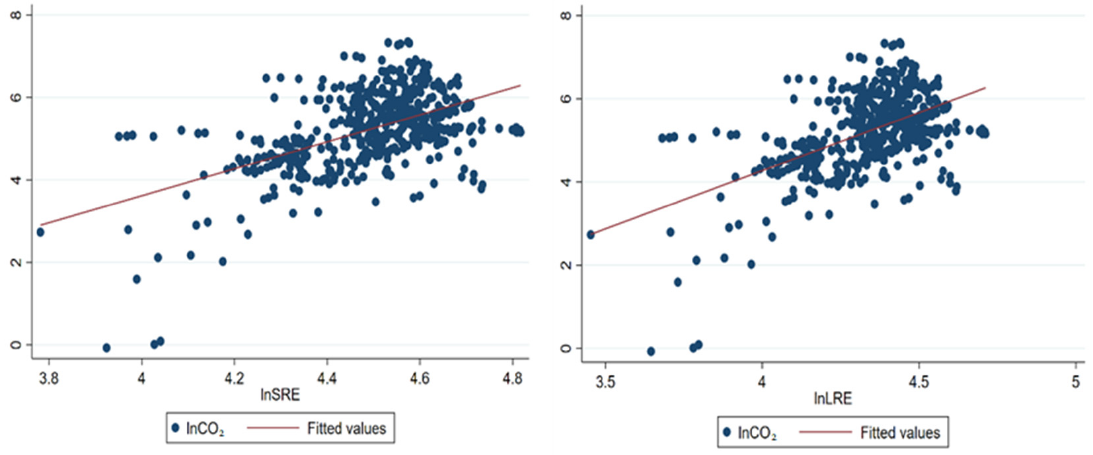
Figure 6. Correlation diagram between RE and CO 2 emissions.